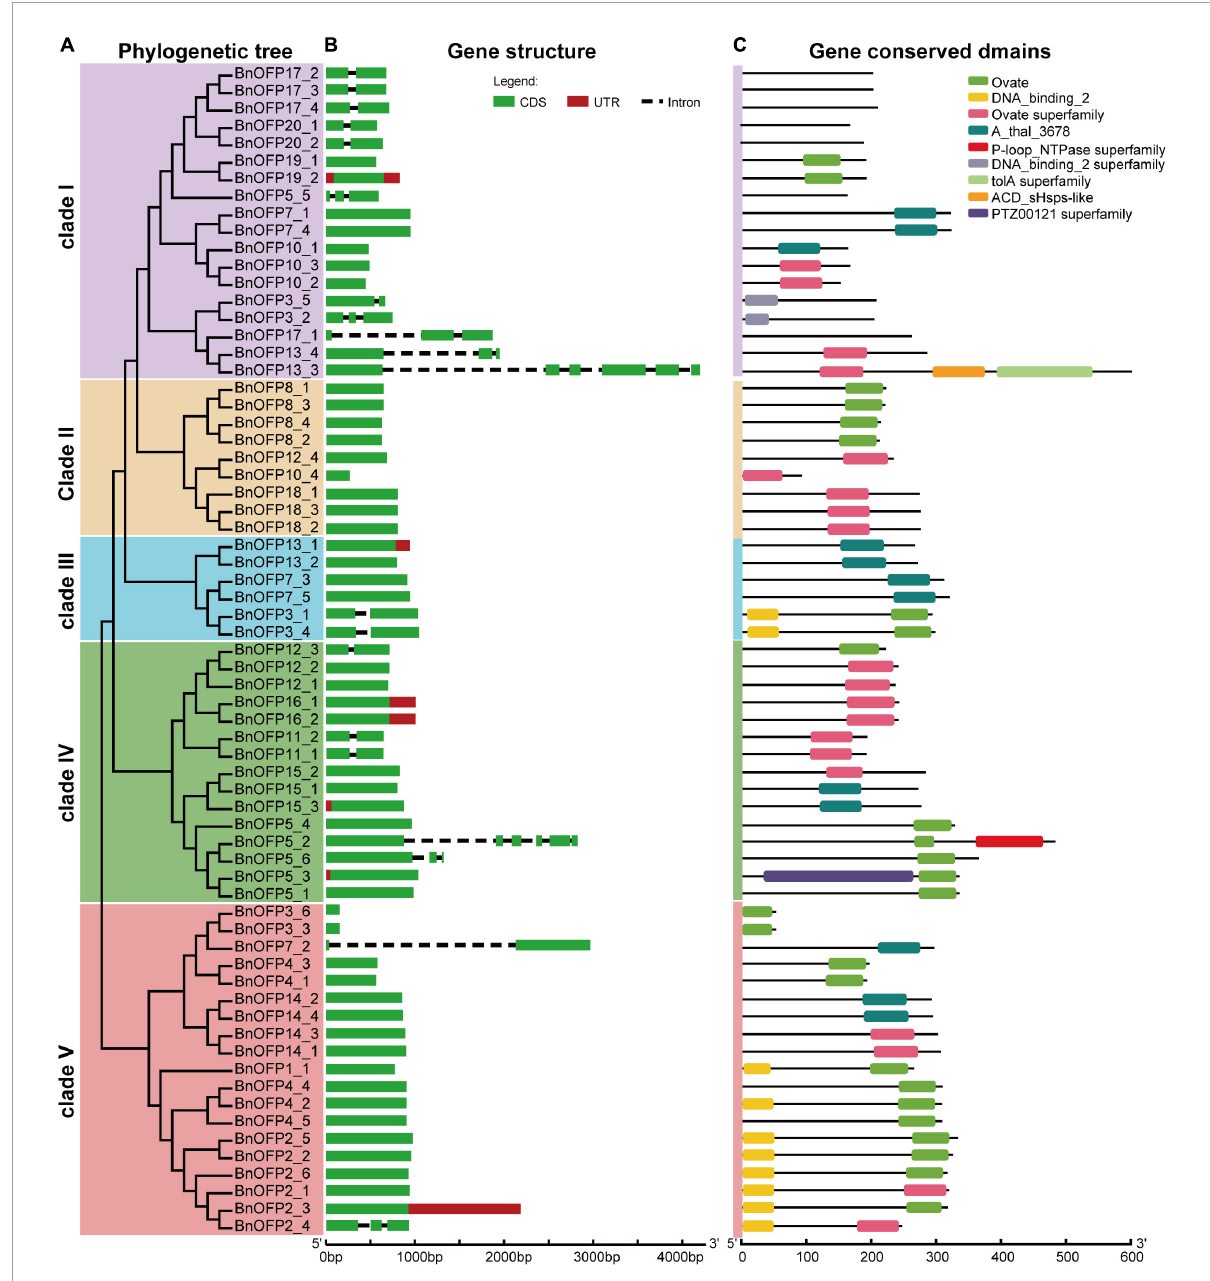
FIGURE4 Gene structure and conserved domains of BnOFPs. (A) Phylogenetic tree of BnOFP genes. The 67 BnOFP genes were classified into five clades, each of which is illustrated with different colors. (B) Gene structure of the 67 BnOFP genes. Boxes represent the CDS and UTR section, and the lines indicate introns. (C) Gene conserved domains of the 67 BnOFP genes. Nine conserved domains are represented in different colored boxes, and the line means non-conserved sequence. Length scale is presented at the